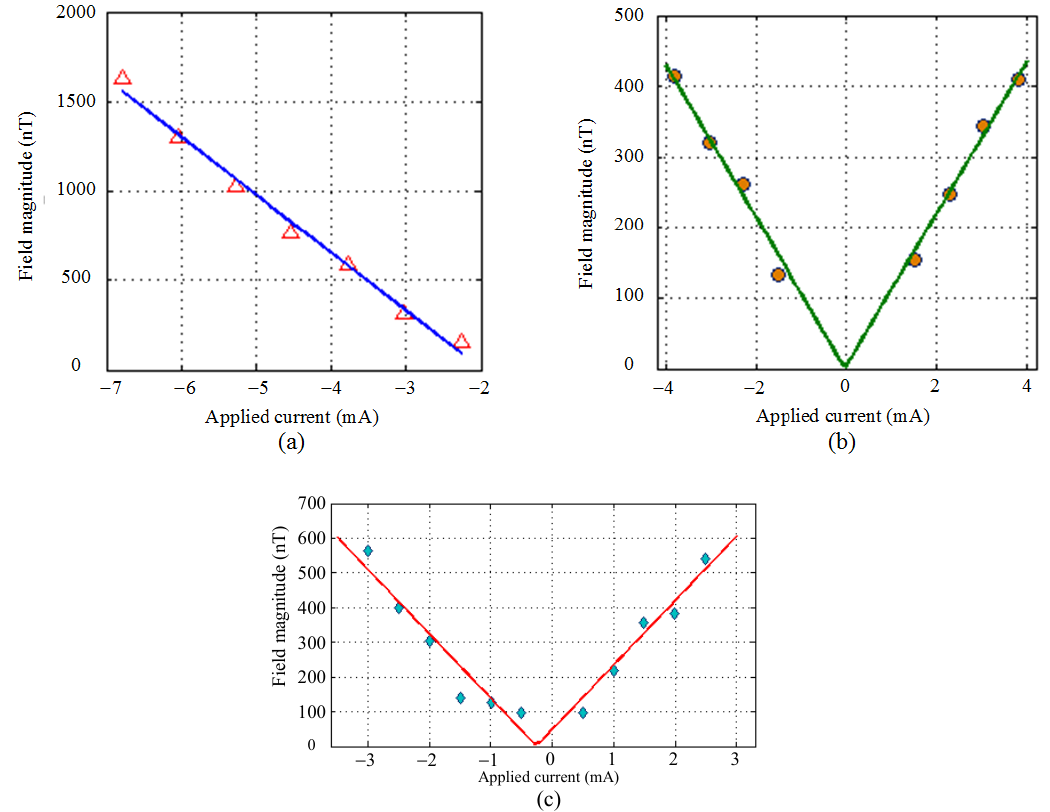
Fig. 4 Linear relationship between the applied current intensities and the sensed field magnitudes in three directions. The dots represent the obtained field from phase-frequency analysis, and the solid line represents the fitting curve: (a) the linear coil constant fitting in the X axis, (b) the linear coil constant fitting in the Y axis, and (c) the linear coil constant fitting in the Z